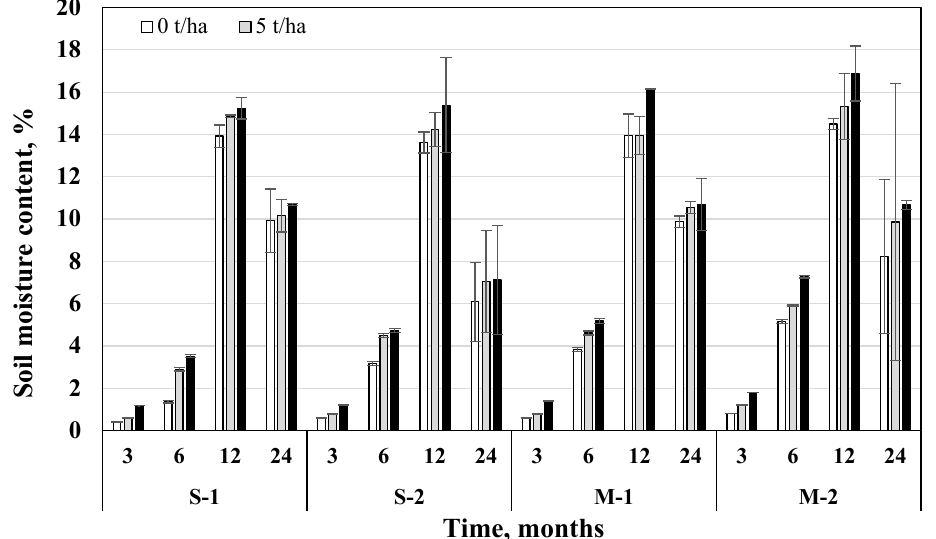
Figure 10. Influence of biochar on changes in soil moisture content in different tillage-fertilization systems (S—shallow no-till, M—direct sowing, 1—unfertilized, 2—fertilized) after 3, 6, 12, and 24 months from the beginning of the experiment, n = 2.